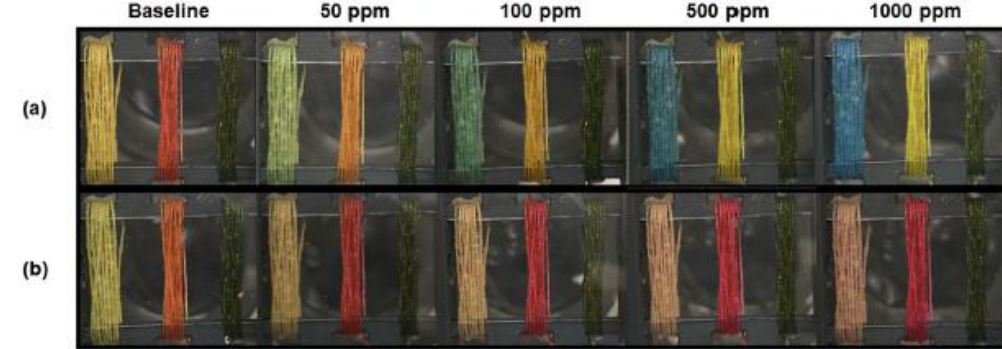
Figure 8. Optical images of BTB (bromothymol blue), MR (methyl red), and MnTPP (5,10,15,20-Tetraphenyl-21H,23H-porphine manganese(III) chloride) devices for different concentrations of ( a ) NH 3 or ( b ) HCl [83].